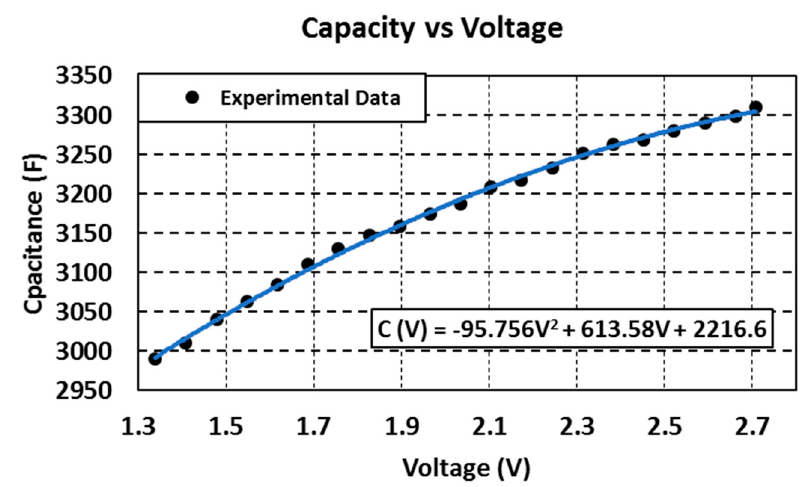
Figure 5. Capacitance evolution as a function of the voltage in the SC.